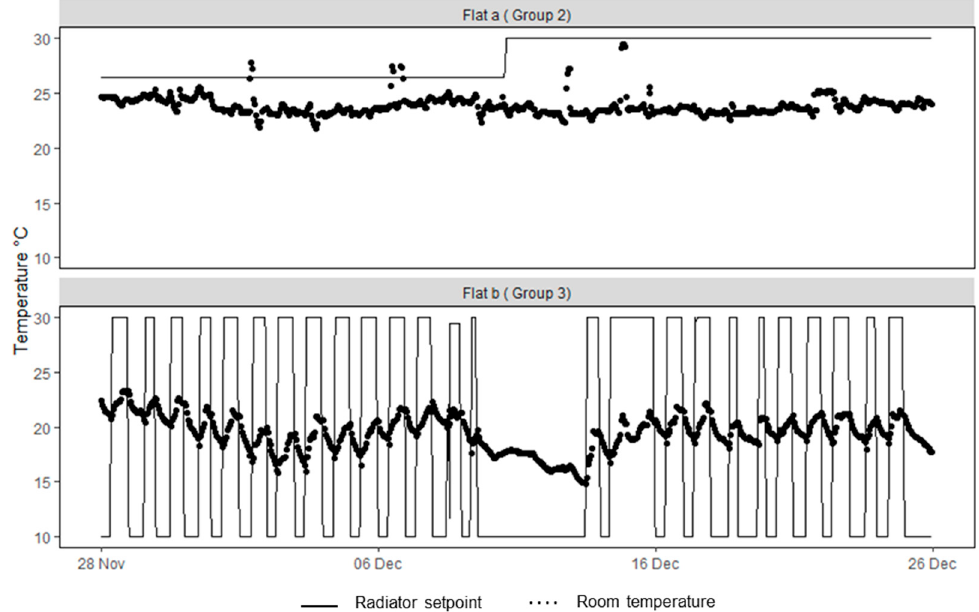
Figure 6. Patterns of STV setpoint adjustment in living rooms from 28 November to 26 December 2019. “Flat a” shows only one small adjustment of the setpoint (less than 5 °C) in the month. The room temperature never reaches the setpoint specified, suggesting the radiator cannot achieve that temperature. The behavior of “Flat a” is comparable to that expected from a house that has a “feedback” theory. In contrast, “Flat b” adjusts the setpoint from minimum to maximum daily. During the period between 6 and 16 December, no setpoint change was recorded. This, in combination with the temperature drop and the time of the year, suggests that the occupants were away from the household.